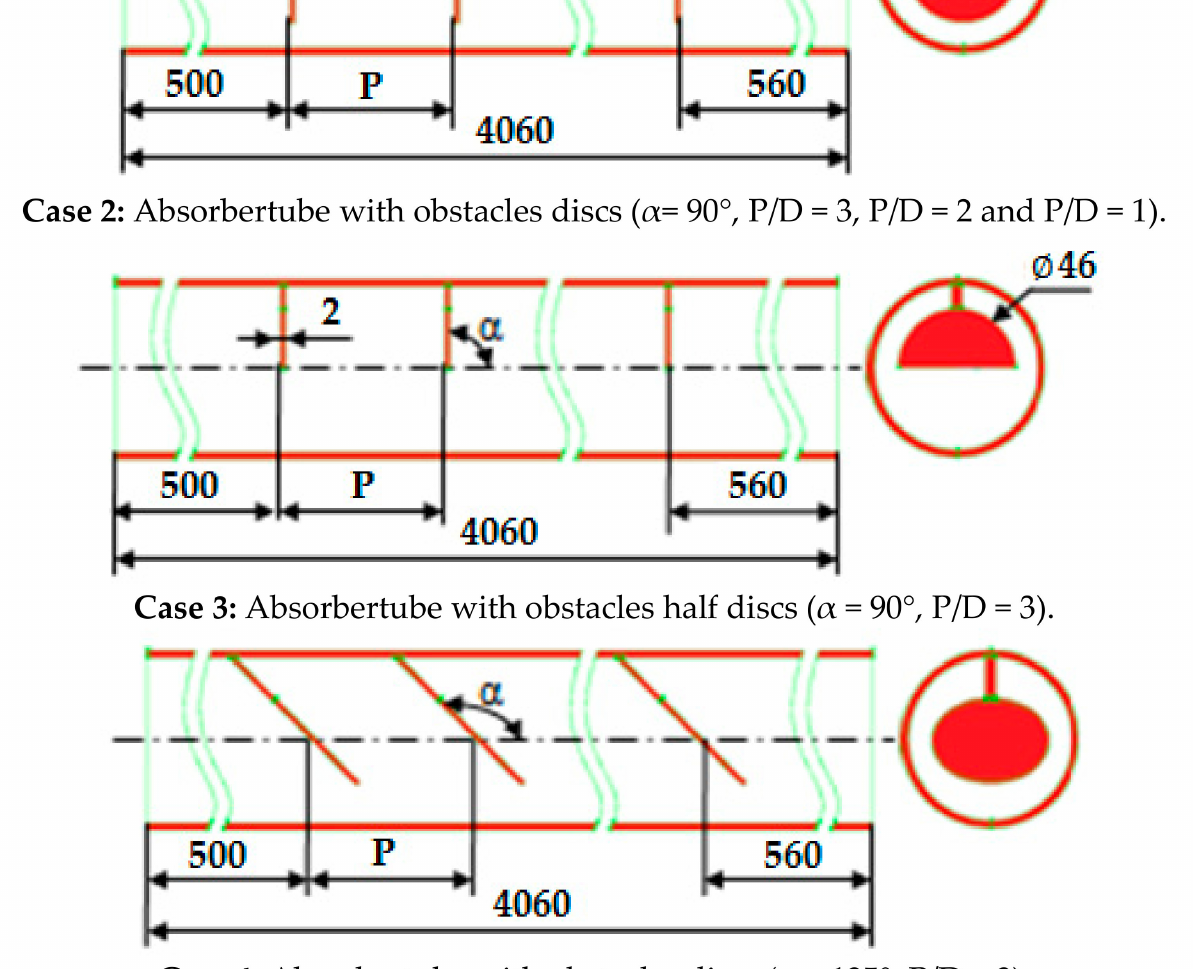
Figure 2. Physical model of absorber tube with